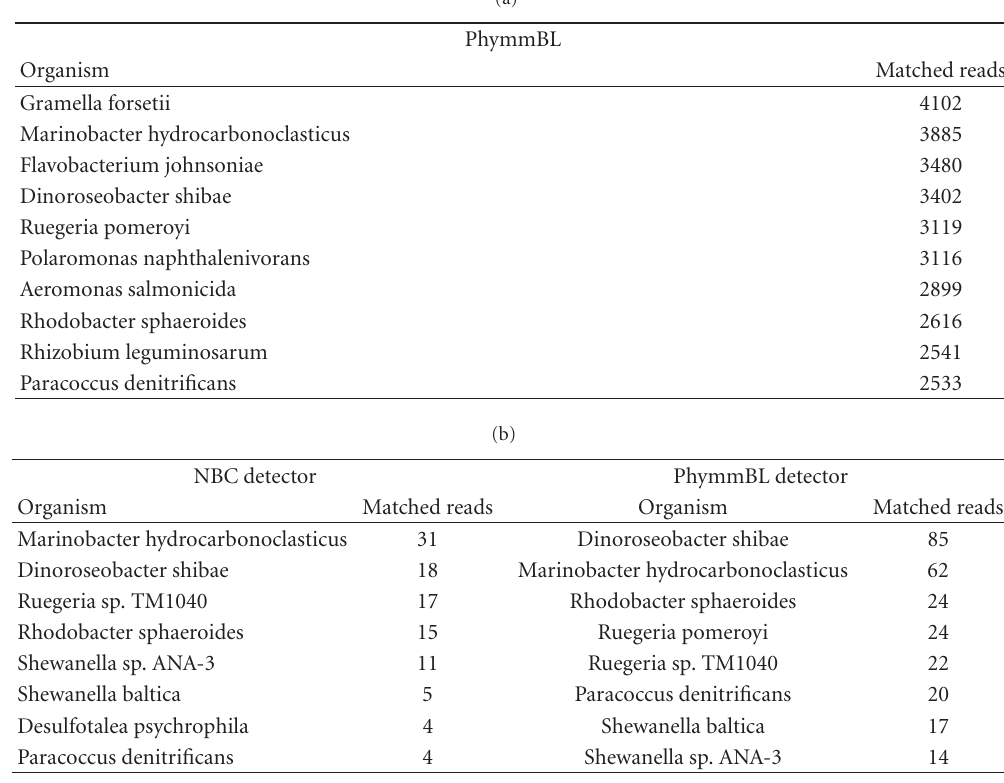
Table 4: The table shows the distribution of top 10 most abundant species reads of PhymmBL and the top-8 species-reads passed the species resolution detectors for the red soudan acid mine drainage dataset, using the 635-genome training database.